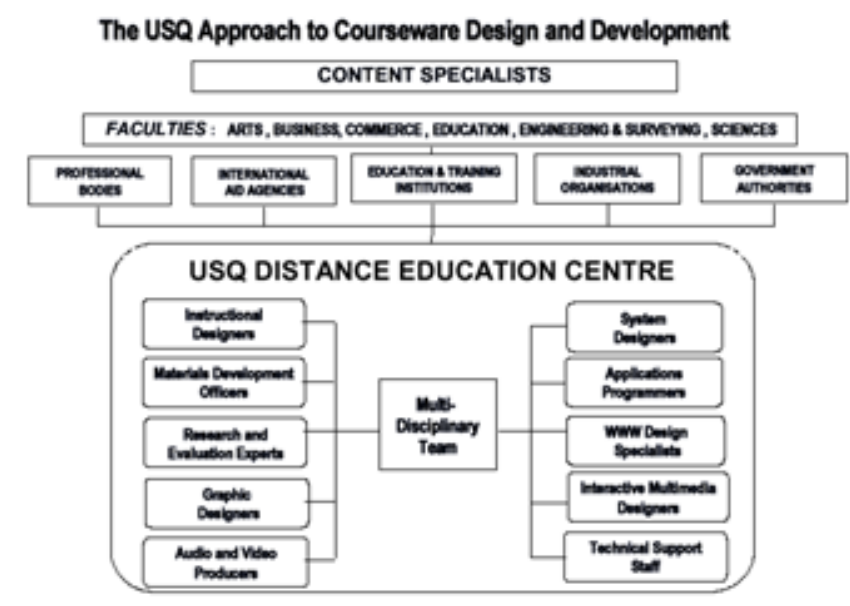
Figure 3: Unit Team Model (Below/End)